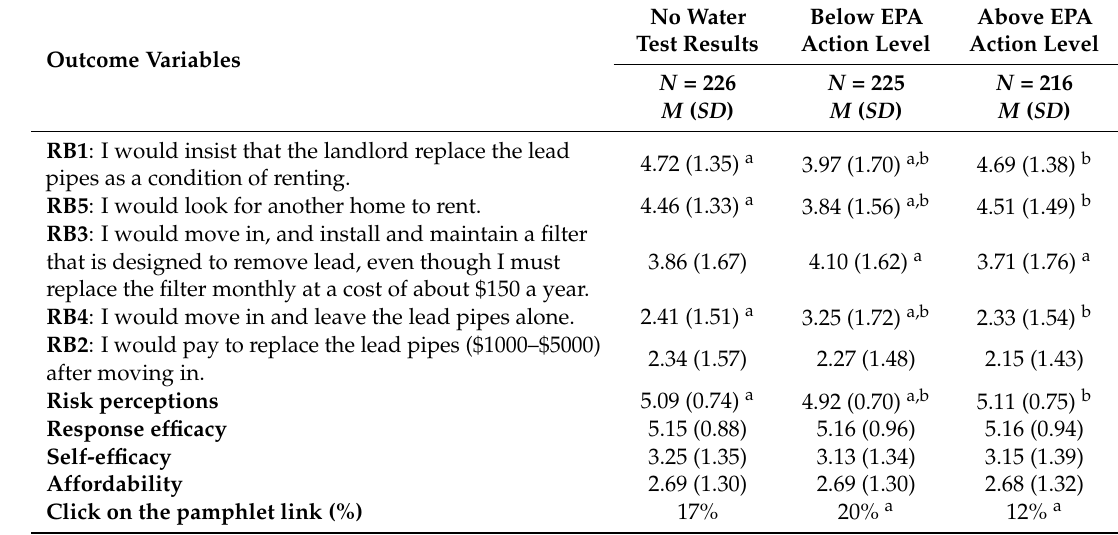
Table 3. Mean differences between disclosure conditions in the landlord/renter study (willingness items sorted by mean willingness to adopt action within Study 1).